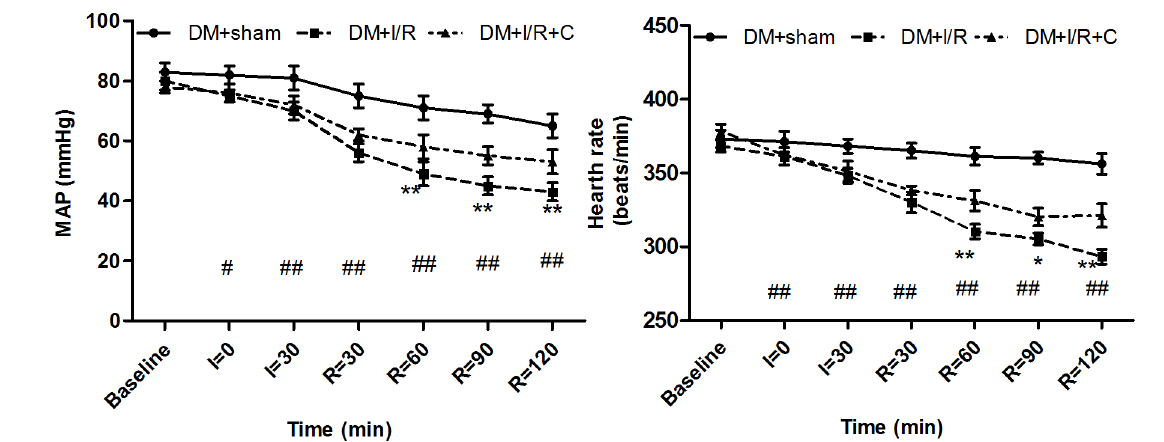
Figure 3. Effects of catalpol on hemodynamic parameters. # P < 0.05 versus the DM+sham group. ## P < 0.01 versus the DM+sham group; * P < 0.05 versus the DM+I/R group; ** P < 0.01 versus the DM+I/R group.